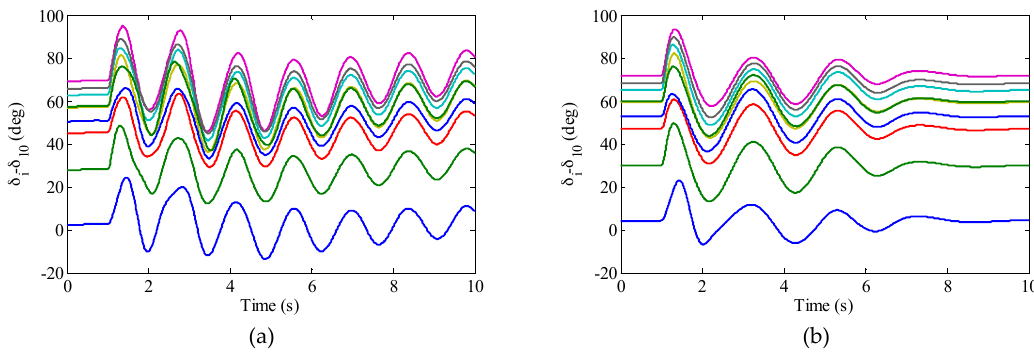
Figure 13. Rotor angle δ i - δ 10 response against a short circuit under operating condition 2. ( a ) Conventional PID governor controller; ( b ) Nonlinear synergetic governor controller.